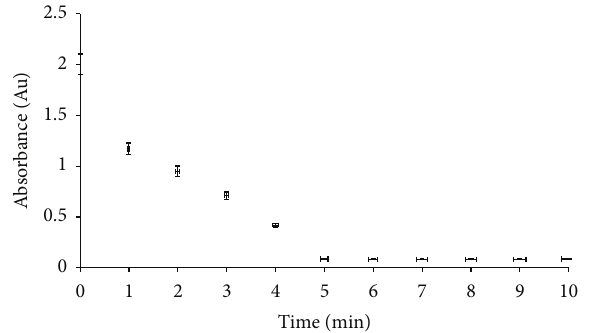
Figure 2: Optimization of the time needed for maximum removal of chlorophyll, at optimal MIP quantity of 850 mg and pH 7. 𝑛 = 3